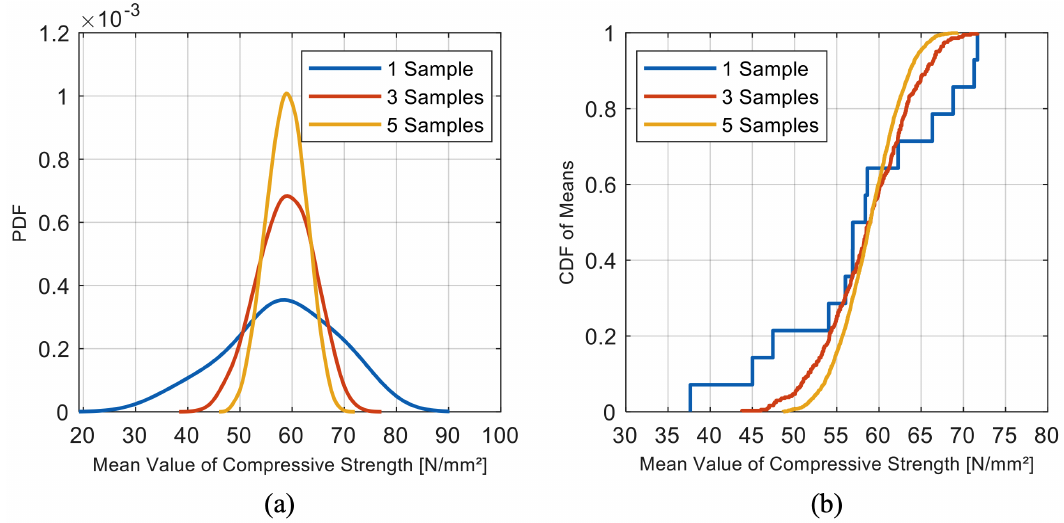
Figure 6. (a) Kernel density function and (b) eCDF of the simulation results of the mean value using 1, 3 and 5 drill cores.